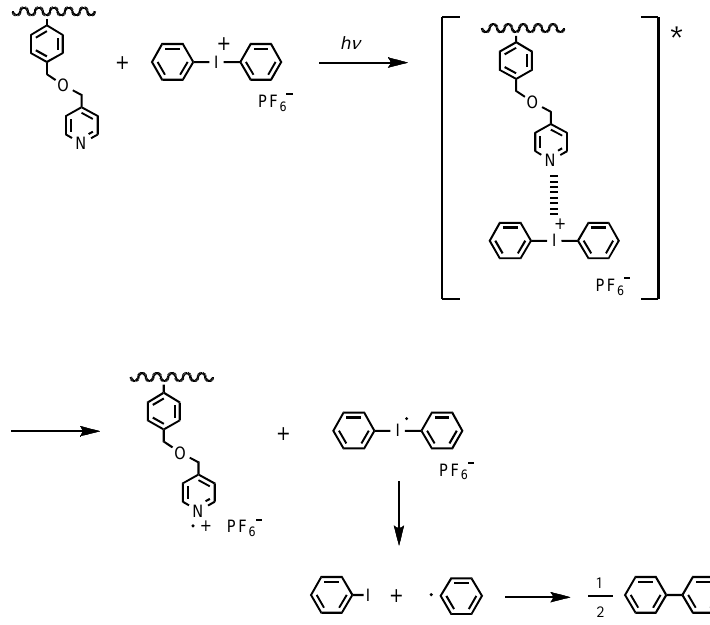
Figure 11. The variation in the signal intensity ratio of the methylene protons in 1 H NMR (I ), hydrodynamic diameter (D NMR DLS during